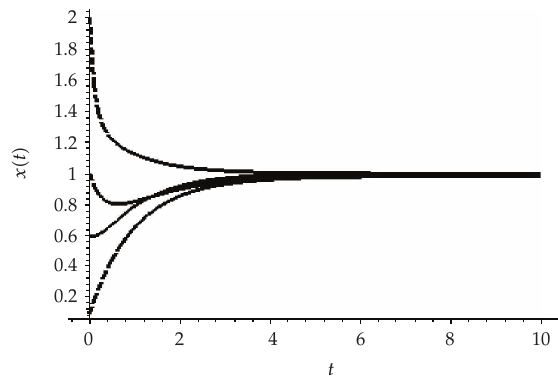
Figure 1: Dynamic behaviors of the first component x (cid:3) t (cid:4) of the solution (cid:3) x (cid:3) t (cid:4) ,y (cid:3) t (cid:4) ,z (cid:3) t (cid:4)(cid:4) T to system (cid:3) 3.1 (cid:4) with the initial condition (cid:3) 0 . 1 , 0 . 1 , 0 . 1 (cid:4) T , (cid:3) 1 , 1 , 1 (cid:4) T , (cid:3) 2 , 3 , 4 (cid:4) T , and (cid:3) 0 . 6 , 1 , 2 (cid:4) T , respectively.